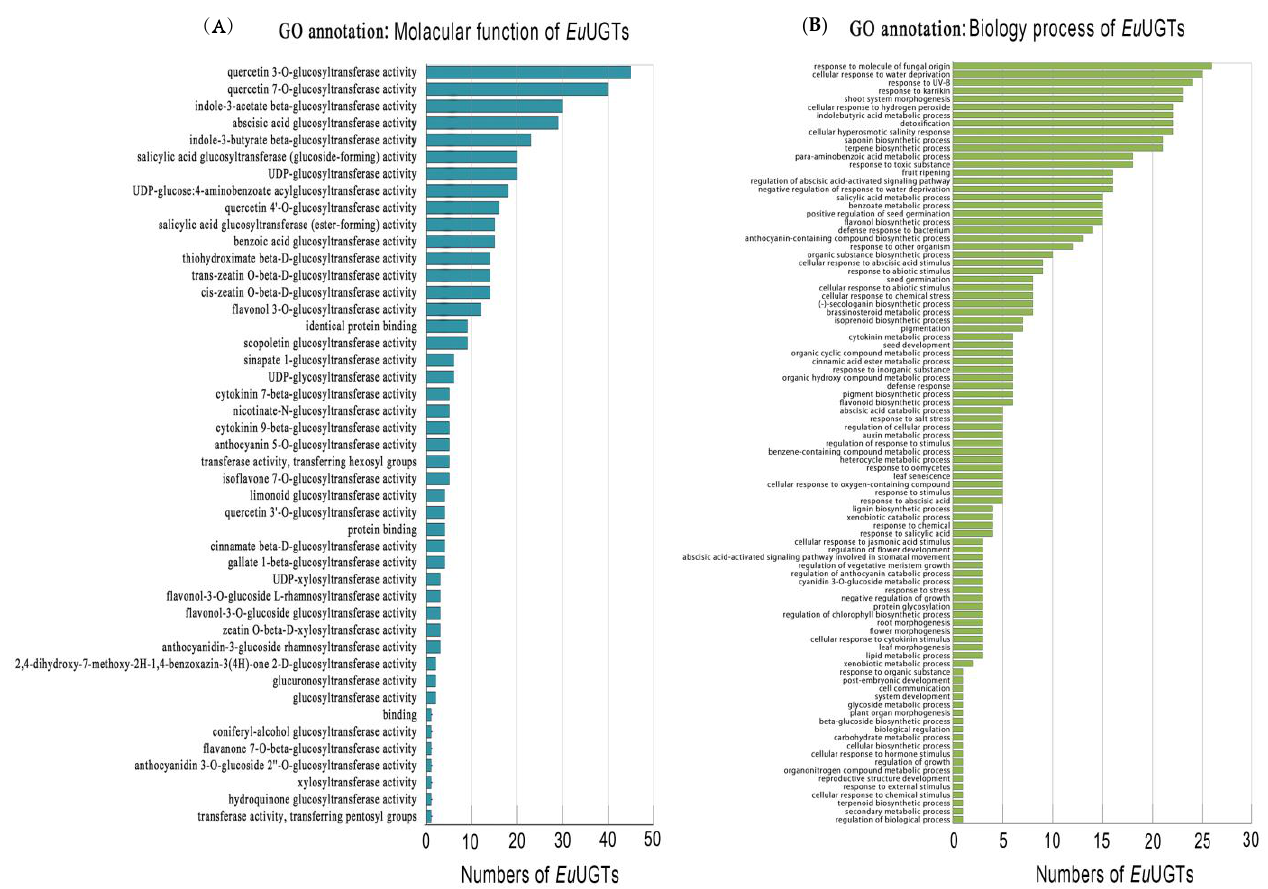
Figure 5. GO annotation of Eu UGTs. ( A ) Enrichment of Eu UGTs in molecular function; ( B ) enrichment of Eu UGTs in biological processes.